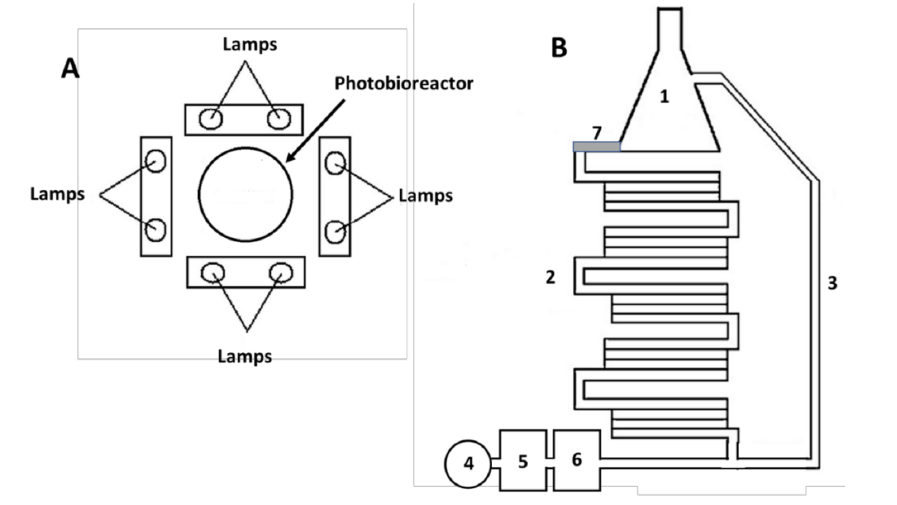
Figure 1. Schematics of the helicoidal photobioreactor utilized to cultivate Arthrospira platensis . Aerial ( A ) and frontal view ( B ). (1) 5.0-L Erlenmeyer flask; (2) cylindrical-shaped glassy helical photostage; (3) vertical cylindrical photostage; (4) air pump; (5) NaOH solution; (6) CaCl 2 -containing closed vessels; (7) PVC